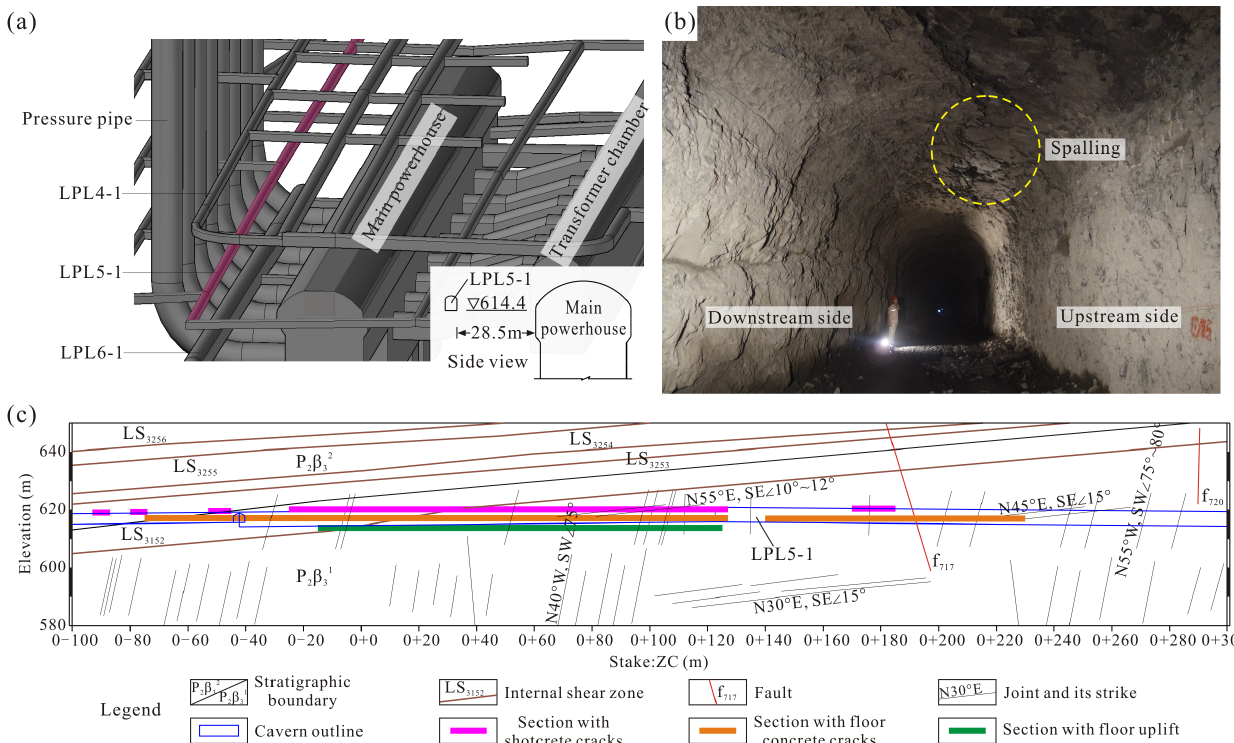
Figure 4. Basic information about the drainage gallery LPL5-1: ( a ) location, ( b ) spalling at the upstream arch during excavation and ( c ) a geological cross-section along the axis and the final axial distribution of